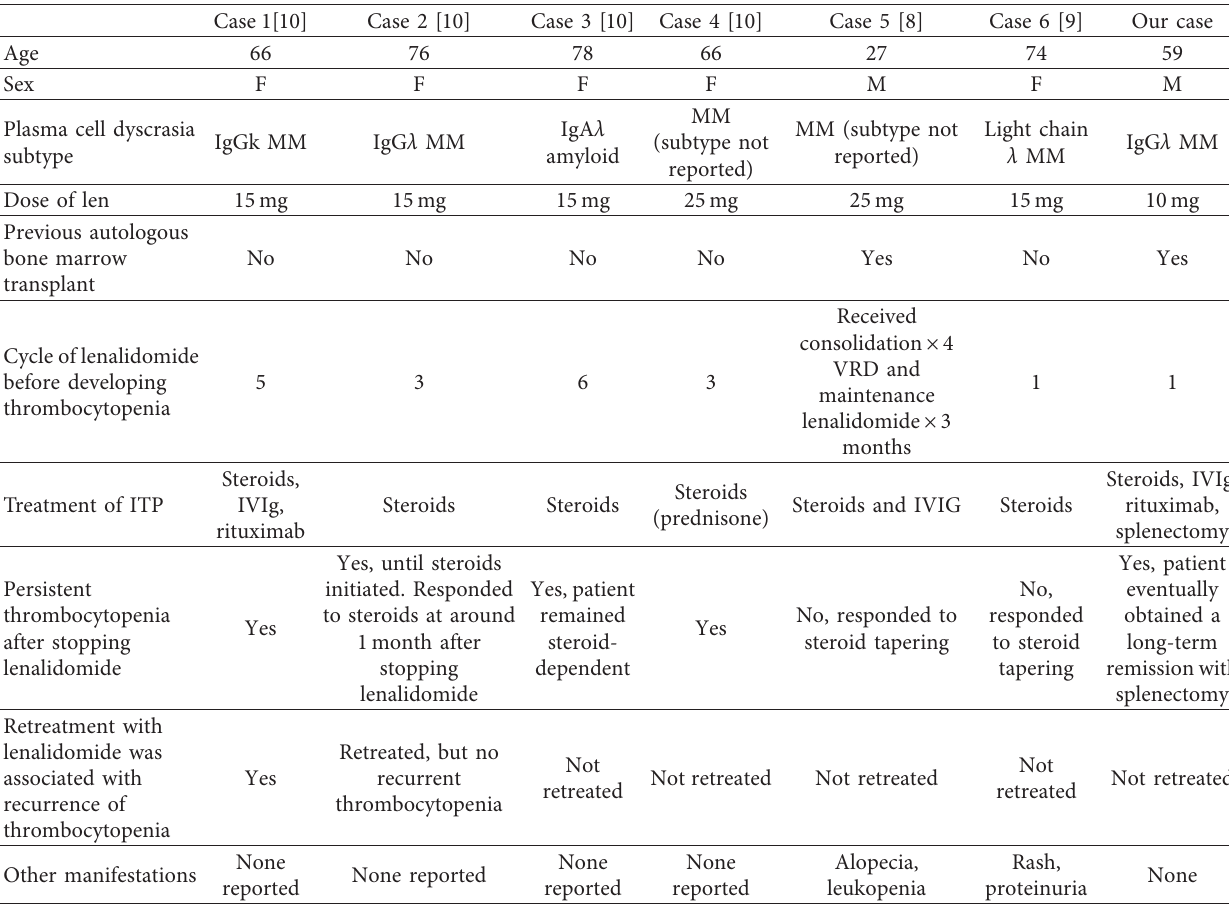
Figure 4: Literature search results, exclusion, and inclusion. A MEDLINE search for the keywords (lenalidomide) and (ITP) or (lena- lidomide) and (immune thrombocytopenia) resulted in 24 results. 23 of these results were excluded, and 1 was assessed and included. Google Scholar was also searched using the keywords (lenalidomide) and (ITP). There were 569 results. 566 of these results were assessed and excluded as not related to lenalidomide and ITP. 3 of the 569 results were included in our report. Because one of the included Google Scholar results was a duplicate with the included MEDLINE, there were a total of 3 reports that were identified that those were case reports or case series of lenalidomide-associated ITP. Table 1: A comparison of the cases of lenalidomide-associated ITP reported in the literature along with our